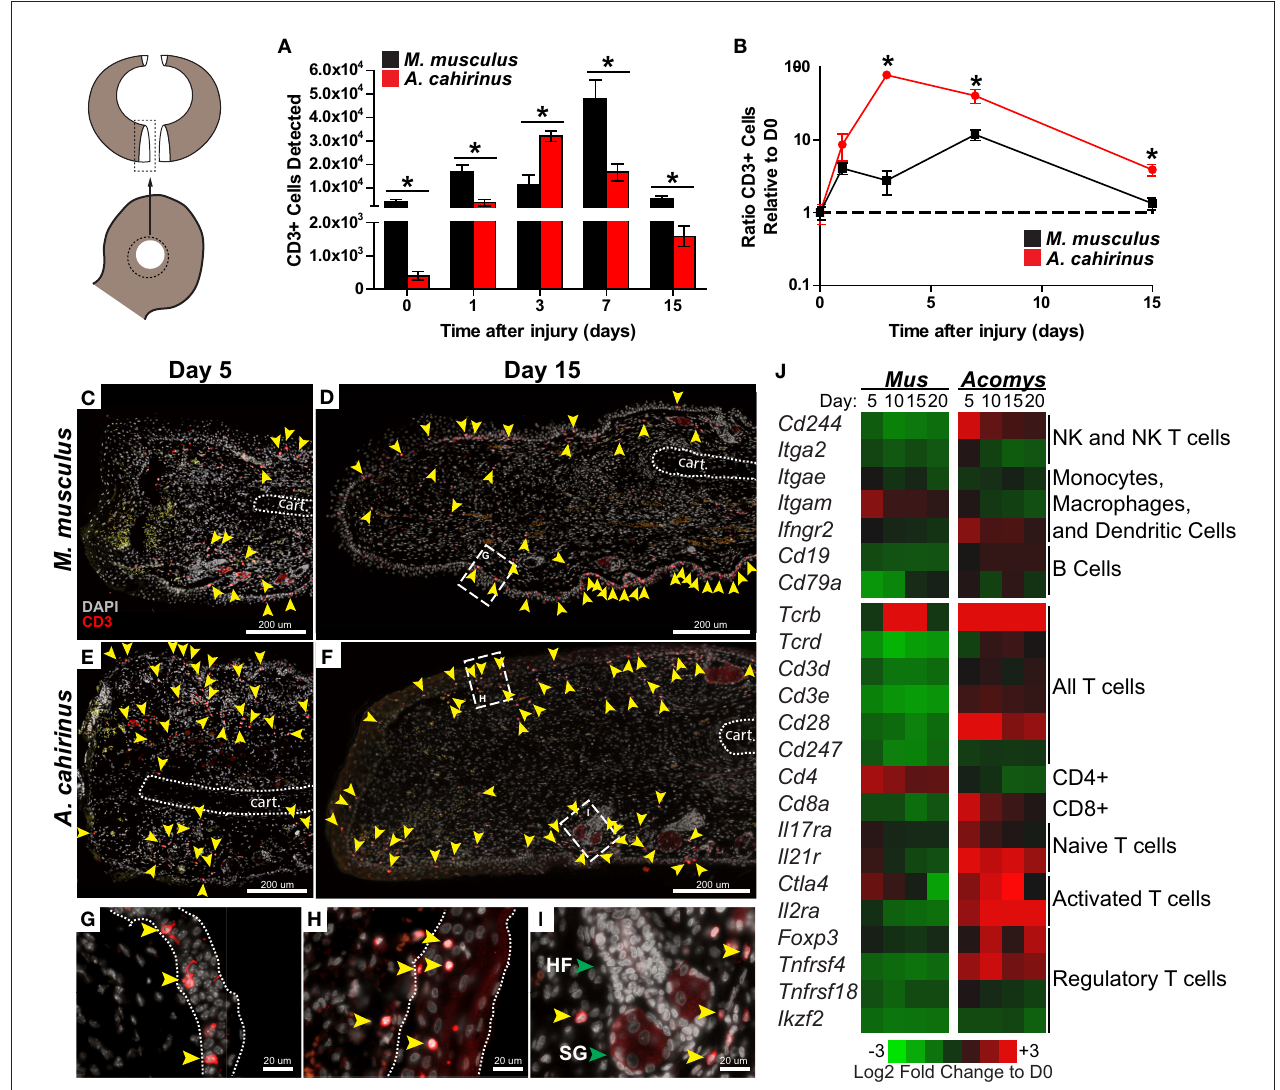
FIGURE 4 | The regeneration microenvironment is primed by greater T cell influx and activated T REG signature . (A) Comparison of total CD3 cells quantified by flow + cytometry from disassociated ear pinna and (B) the ratio relative to uninjured tissue for M. musculus (black) and A. cahirinus (red). Data represent mean and S.E.M. and n 4 or 5. An * denotes P < 0.05 for pairwise comparison within the day between species for Tukey-Kramer HSD post-hoc test. (C–I) Representative = immunohistochemistry for CD3 (red) counterstained with DAPI (gray) at the proximal wound margin (amputation plane can be determined from the end of the cartilage—indicated by the dotted line) from D5 and D15 after injury of M. musculus (C,D) and A. cahirinus (E,F) . More T cells (yellow arrowhead) were present throughout the wound bed and were mainly found in the dermis of A. cahirinus compared to M. musculus . The T cells associated with epidermis (boundaries indicated by the dotted line) tended to be spindle-like in M. musculus (G) , while rounded in A. cahirinus (H) . The dermal T cells in A. cahirinus also tended to be in close proximity to regenerating epidermal appendages (I) . N 4 and bar equals 200 µ m (C–F) or 20 µ m (G–I) . Cartoon depicts the sampled area of the ear punch. (J) Heatmap of = differential gene expression compared to uninjured tissue suggests that the regeneration microenvironment contains a substantial NK,